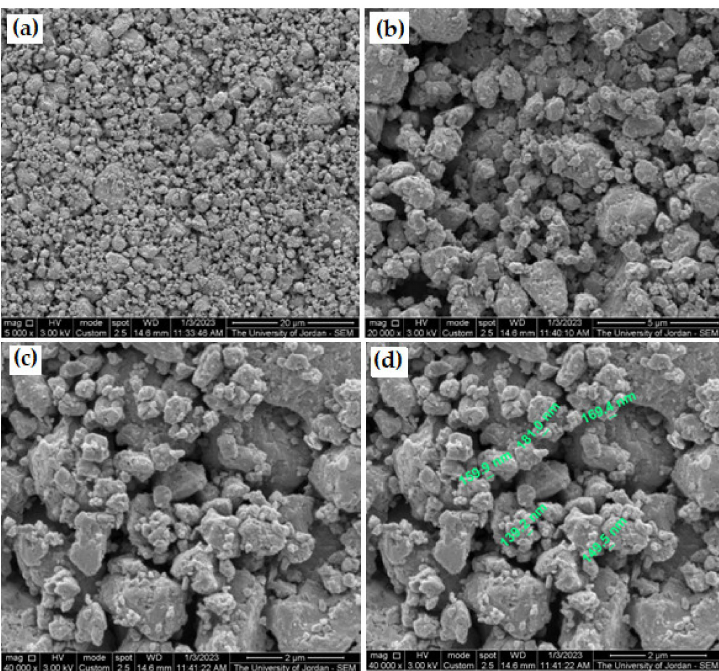
Figure 6. SEM micrographs (SEI) of galena powder after 15 min milling time using different magnifi-